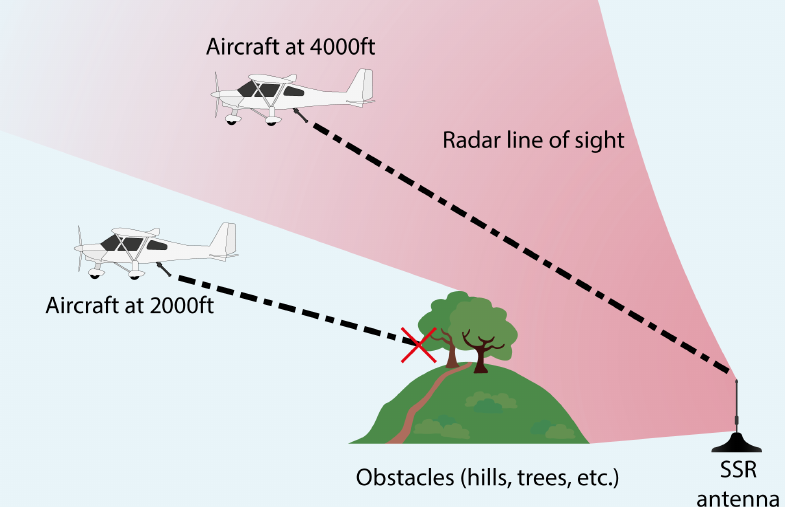
Figure 1. An aircraft at a low altitude is difficult to track with ADS-B/Mode-S where the terrain blocks line of sight to the